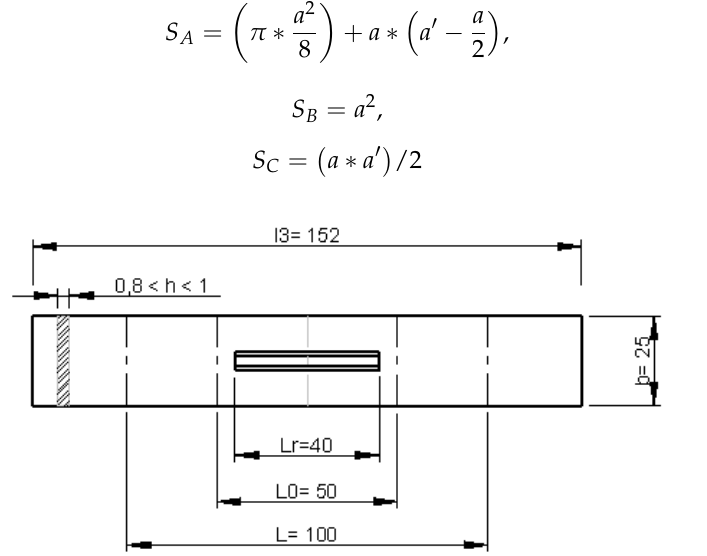
Figure 6. Dimensions of specimen according to standard [31].